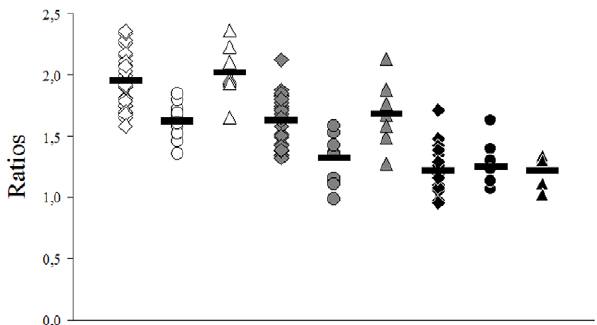
Figure 2. MRS Ratios of brain metabolite in NAWM of MS patients and controls. white , NAA/Cr ratio; grey , NAA/Cho ratios; black, Cho/Cr ratios; squares , RRMS patients (n=27); circles , SPMS patients (n=10); triangles , controls (n=8); bars , means.